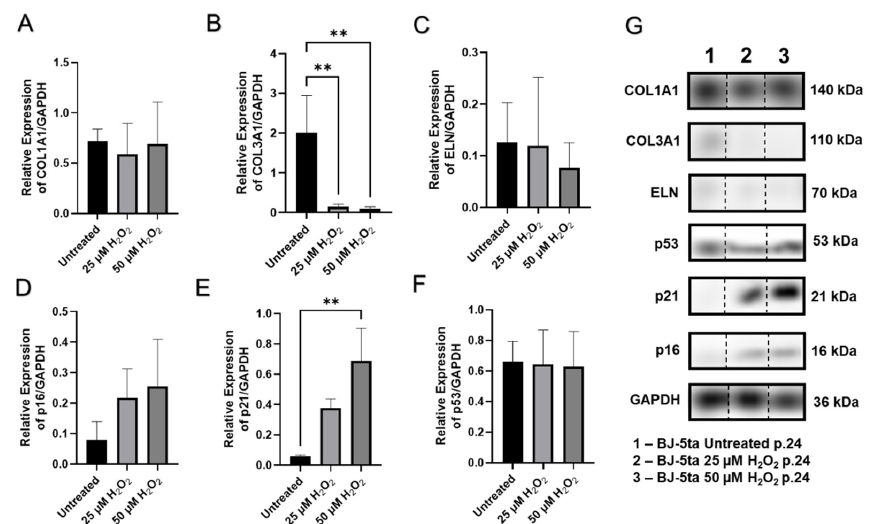
Figure 7. The effects of age on cell cycle checkpoint regulators in BJ-5ta (p.24) fibroblasts. Western blots showing protein levels of COL1A1 ( A ), COL3A1 ( B ), ELN ( C ), p16 ( D ), p21 ( E ), and p53 ( F ). Relative densitometry was presented as a ratio of target protein to GAPDH ( G ). Data were analyzed with a one-way ANOVA test (Tukey post-hoc multiple comparison test). Significance (p) is indicated within the figures using the following scale: **, p < 0.01. Bars represent mean ± SD. Original Western blot images were included in Figures S10–S16. The samples for each protein were run on the same gel (Figure S10–S16). Since the samples were not run consecutively on the same gel, they were spliced for presentation purposes only. No image enhancements were applied.